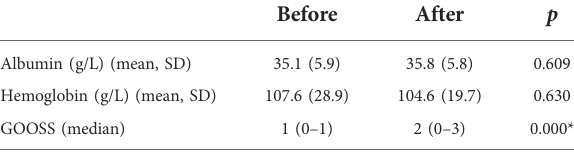
TABLE 3 Comparison before and after intervention.